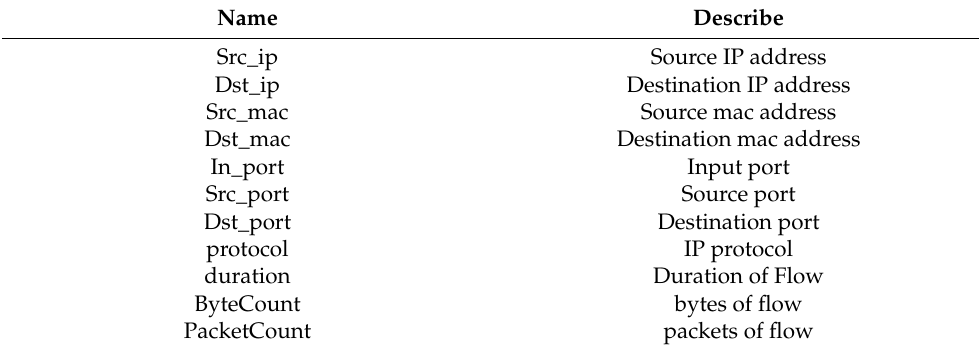
Table 1. Flow table feature vectors.